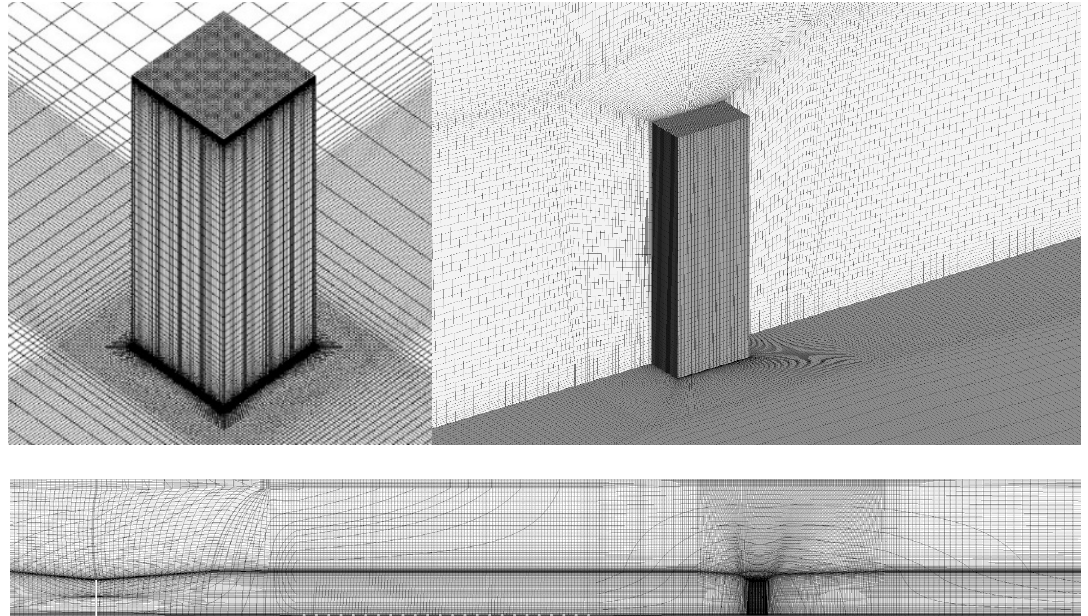
Figure 4. Structured block grid of the high-rise building model. On the left, smooth inflow domain.